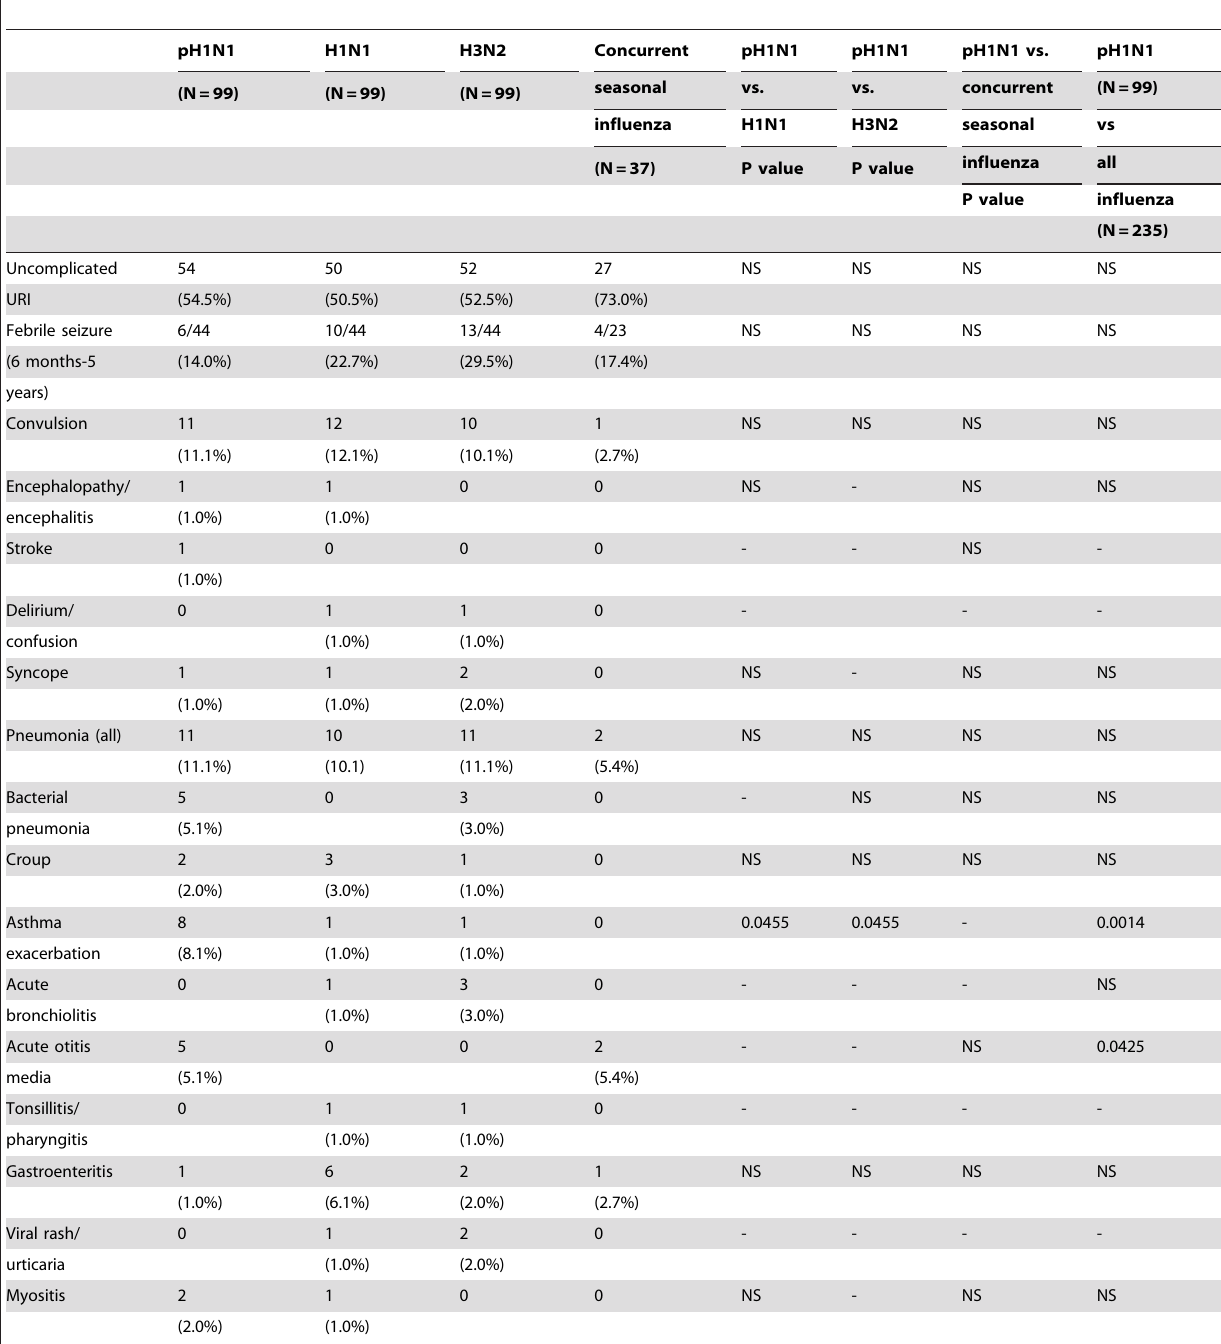
Table 2. Comparison of clinical diagnosis of children hospitalized for influenza A pH1N1 with age- matched controls hospitalized for seasonal H1N1 and H3N2, and with children hospitalized for seasonal influenza concurrently during the study period,